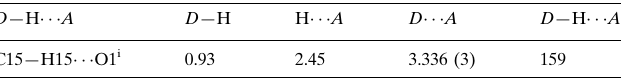
Hydrogen-bond geometry (A˚ , (cid:1)